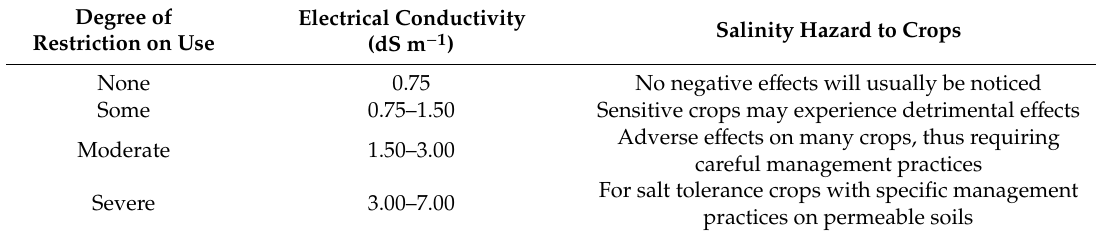
Table 1. Guidelines of irrigation water use relative to salt content and hazard to crops cited by Zaman et al. [42].